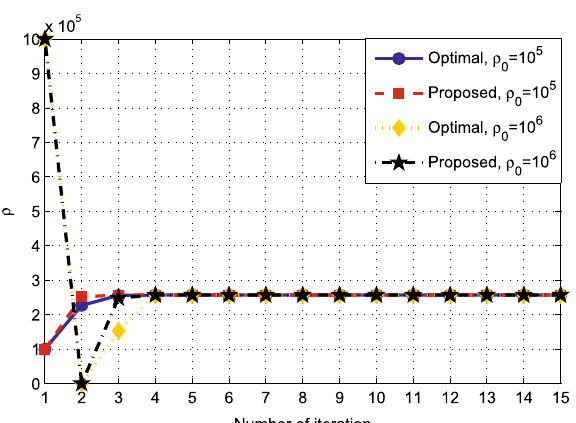
Fig. 7 Energy efficiency of optimal and proposed algorithms for data transmission versus number of